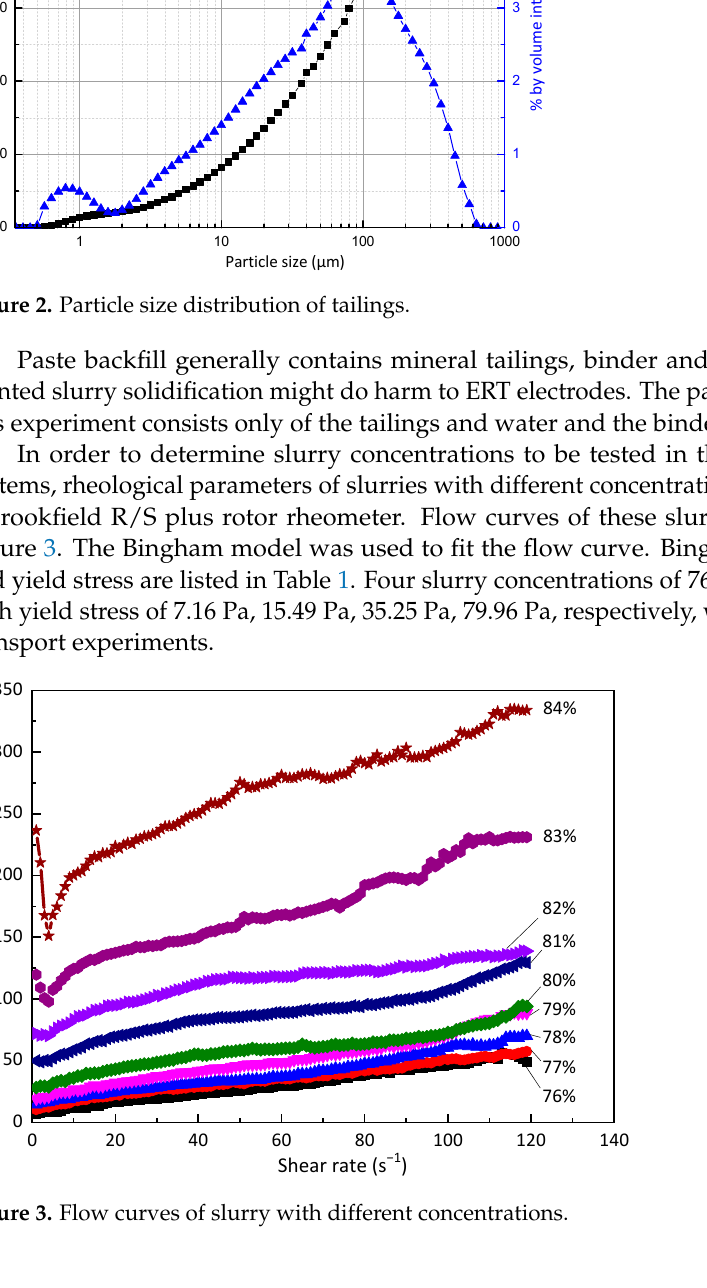
Figure 3. Flow curves of slurry with different